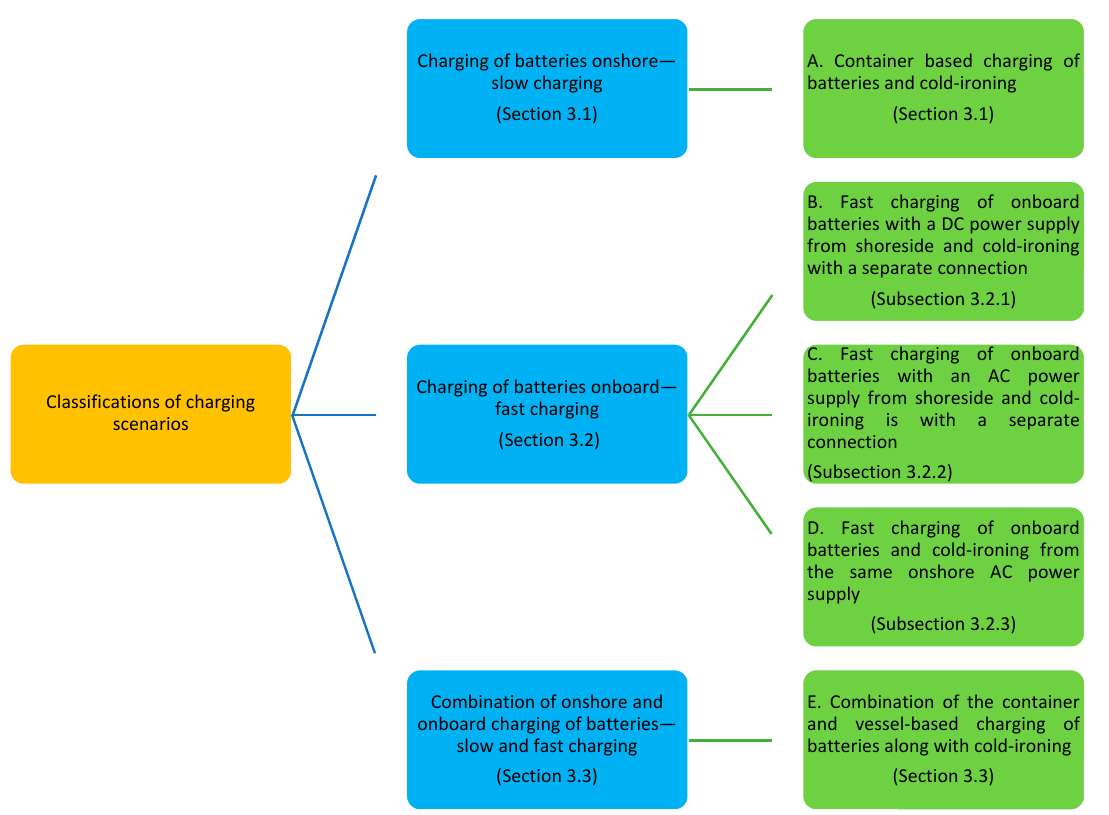
Figure 1. Classification of charging scenarios: onshore (slow), onboard (fast) and a hybrid (slow and fast).